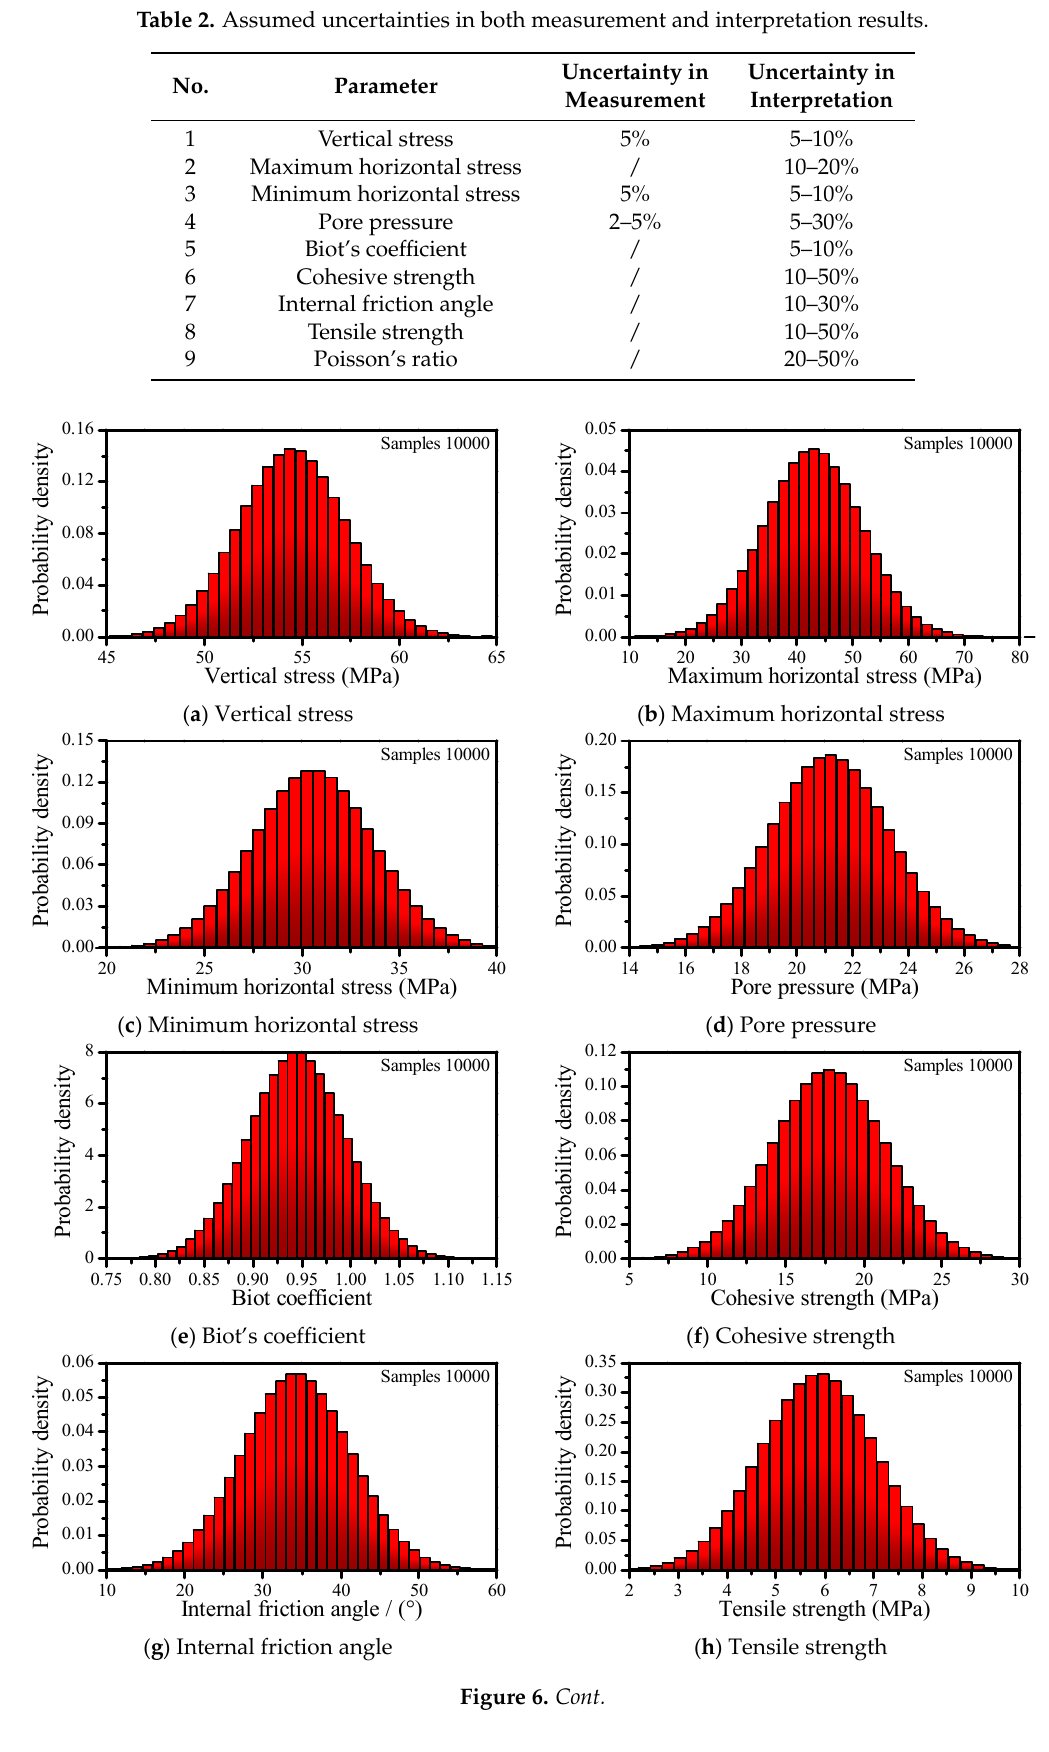
Table 2. Assumed uncertainties in both measurement and interpretation results.